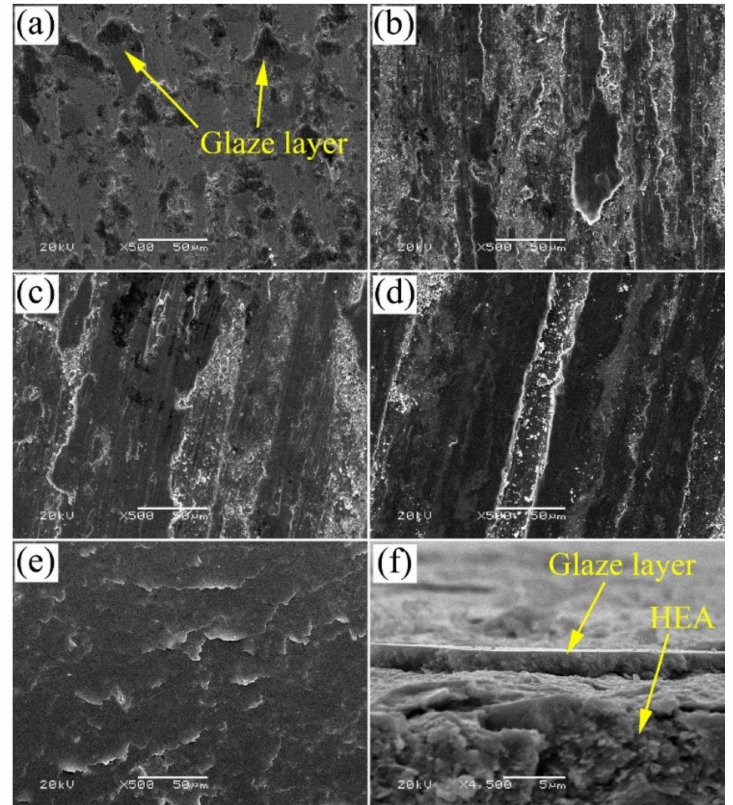
Figure 13. Worn surface of the CoCrFeNiS HEA after tribological tests against Si3N4 at ( a ) 25 ◦ C, ( b ) 200 ◦ C, ( c ) 400 ◦ C, ( d ) 600 ◦ C, and ( e ) 800 ◦ C; ( f ) cross-section of wear track tested at 800 ◦ C